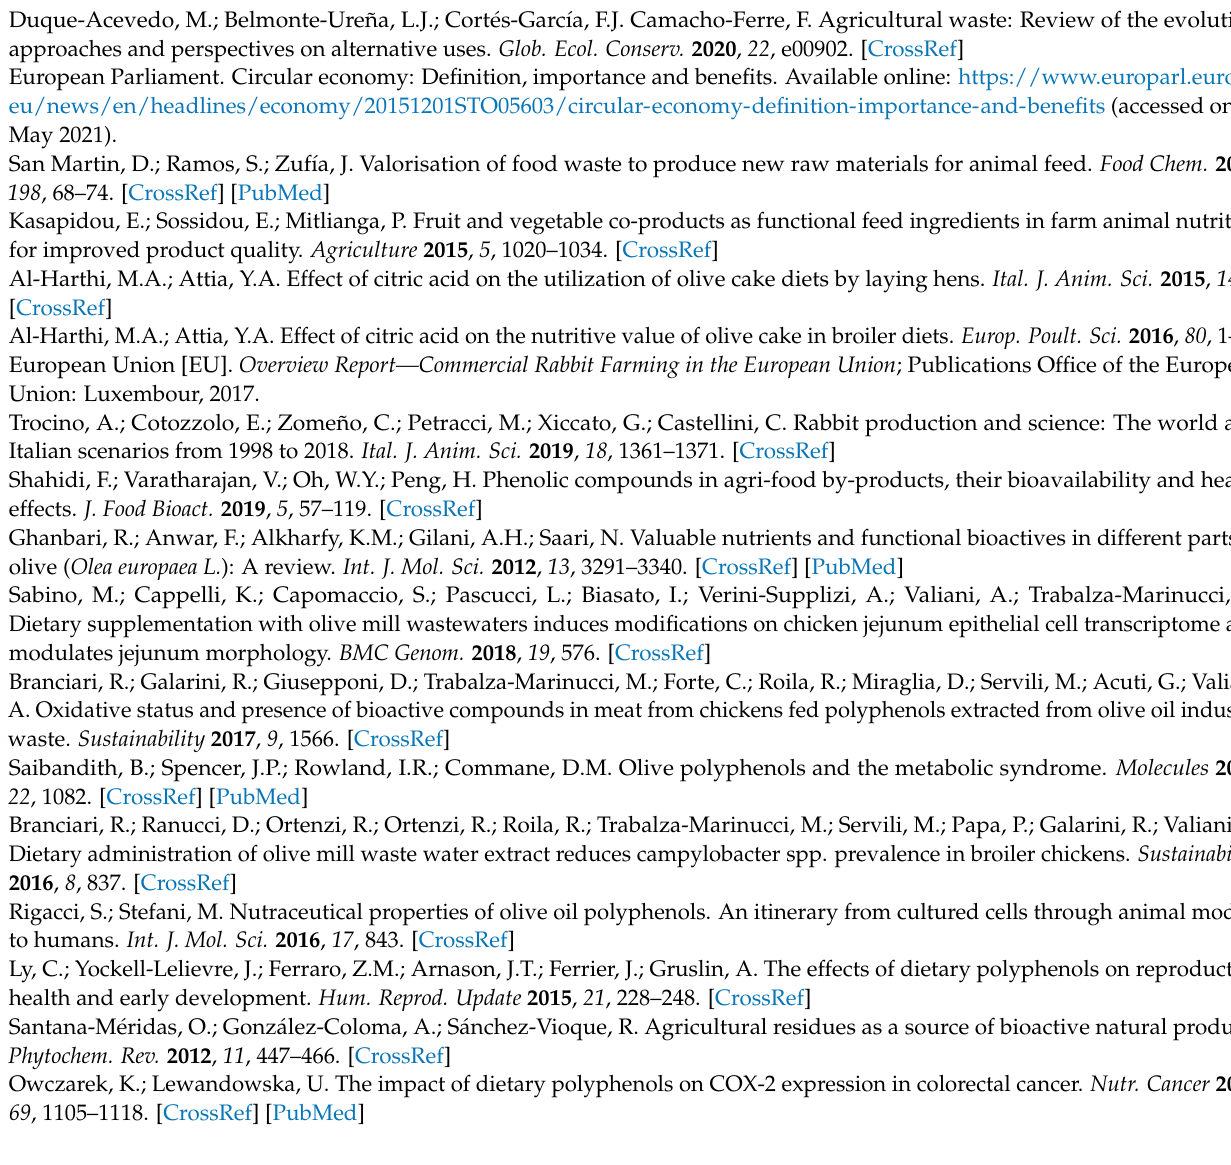
Figure S4: Full immunoblots of BAX, COX2, and beta-tubulin proteins in the ovary of rabbits. Table S1. Ingredients and chemical composition of the commercial pelleted